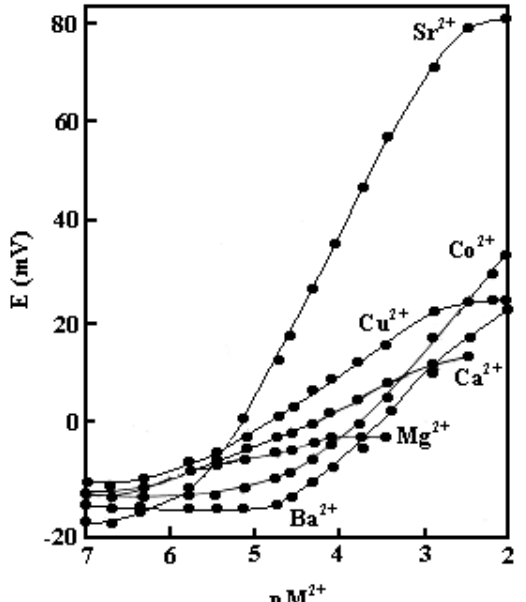
Figure 1. Potential response of various ion-selective membranes based on ionophore L. Conditions: membrane ingredients, 2% L, 30% PVC, 1.7% STP and 66.3% AP, internal solution, 1.0 · 10 -3 M of the corresponding cations for each ion-selective